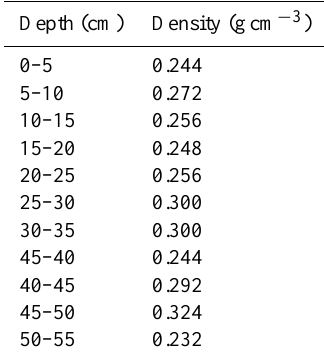
Table 3. The snow density profile, measured at Sodankylä Airport near FIGIFIGO spot on 3 April 2013, 15:00EET.